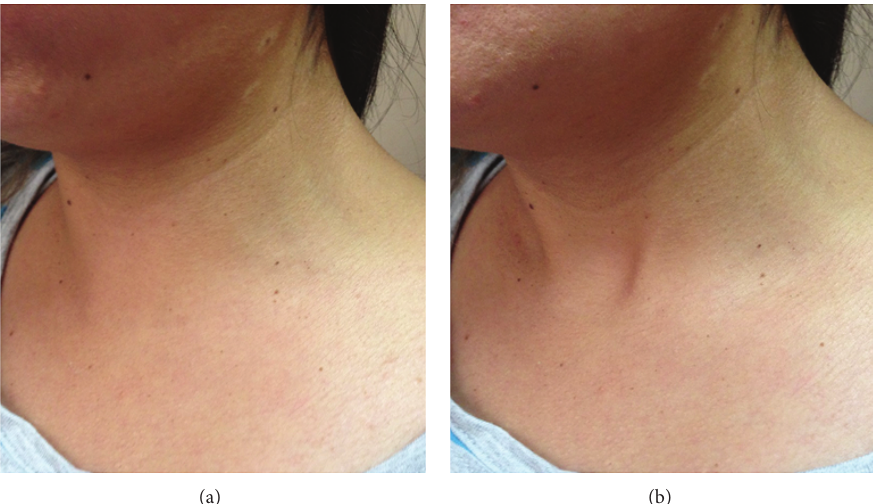
Figure 1: At (a) local subcutaneous augmented volume in the upper frontal chest and lower neck. (b) Normalization of the swelled area after one hour of conservative